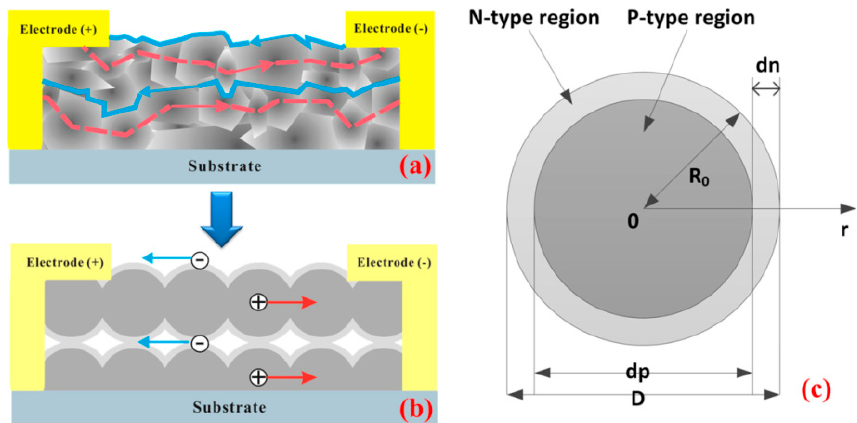
Figure 3. The schematic of the charge separation model, showing ( a ) the conversion of crystallites’ surfaces from p- to n-type, ( b ) the charge carrier transport, and ( c ) the crystallite structure. Reprinted with permission from [61]. Copyright AIP 2014.